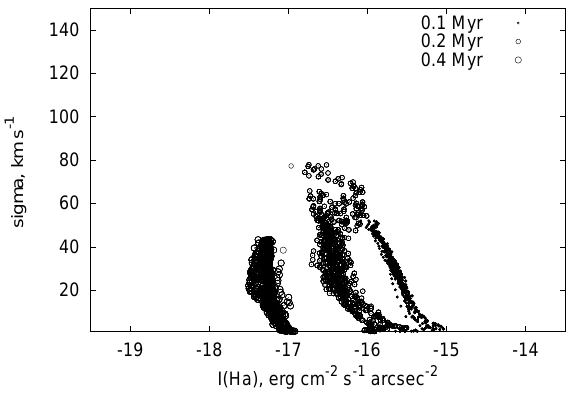
Fig. 3. The I H (cid:11) { (cid:27) diagram for a single SN explosion at t = 0 : 1, 0.2 and 0.4 Myr (from small to large symbols). become smaller for older remnant. The decrease of the ambient density leads to longer evolution, but the maximum velocity dispersion after the beginning of the radiation phase depends only slightly on the ambient density. Fig. 4 (the left-column panels) shows the H (cid:11) intensity (the upper row) and velocity dispersion (the middle row) maps and the I H (cid:11) – (cid:27) diagram (bottom) for the SN rate 1 : 25 (cid:2) 10 − 11 pc − 3 Myr − 1 at t = 0 : 2 Myr. Several SN bubbles